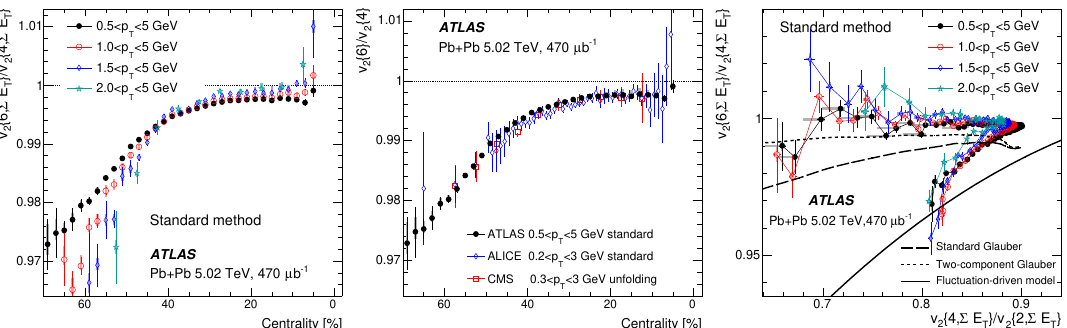
Figure 7 . The centrality dependence of the cumulant ratio v 2 f 6 ; (cid:6) E T g =v 2 f 4 ; (cid:6) E T g for four p T ranges (left panel) and comparison with results obtained with the standard method from ALICE collaboration [34] and unfolding technique from the CMS collaboration [30] (middle panel), and correlation between v 2 f 6 ; (cid:6) E T g =v 2 f 4 ; (cid:6) E T g and v 2 f 4 ; (cid:6) E T g =v 2 f 2 ; (cid:6) E T g compared with models based on initial-state eccentricities (right panel). The error bars and shaded boxes represent the statistical and systematic uncertainties, respectively. One is indicated by a dotted